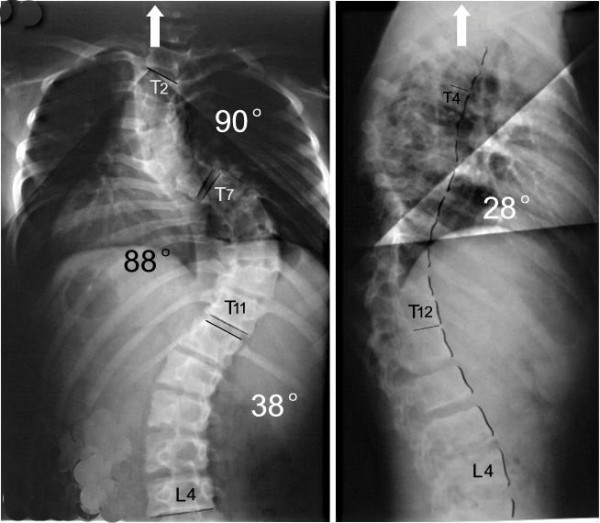
Suspension view shows the flexibility of spine.